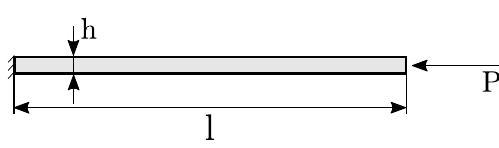
Figure 4. Cantilever beam with end compressive load.